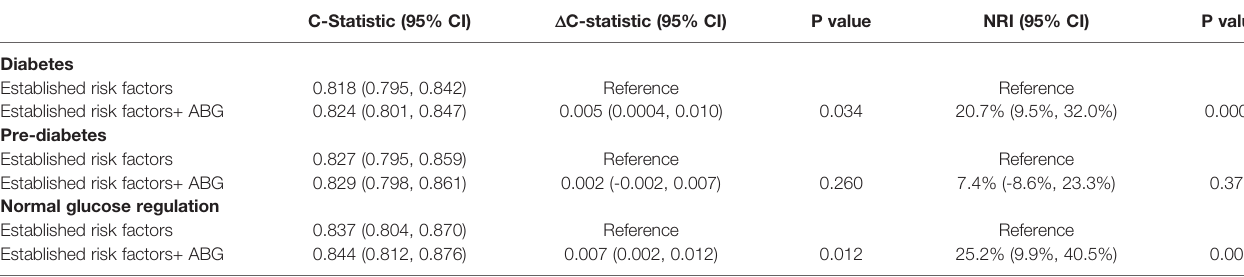
TABLE 3 | Discrimination and reclassi fi cation performance of admission blood glucose levels in predicting 2-year